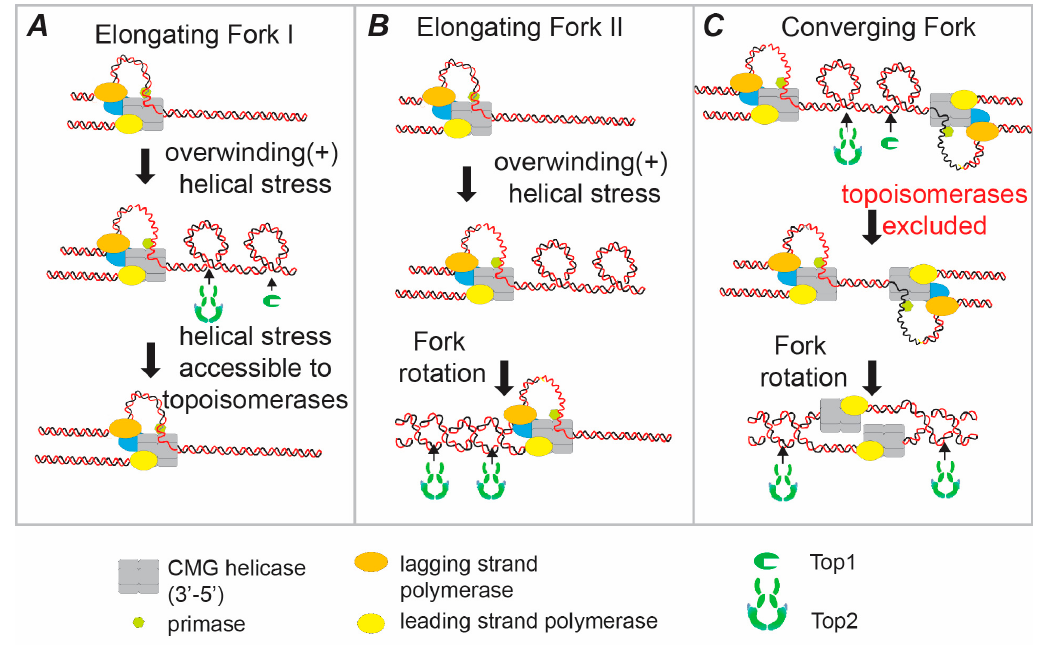
Figure 1. Resolving the topological stress generated by replicative helicase action. During elongation of DNA replication, unwinding of the parental template by the replicative helicase (CMG) separates the parental strands, but does not resolve the intertwining that exists between them. The intertwines between the strands are displaced into the region ahead of the fork leading to overwinding and positive (+) helical stress (shown in figure as positive supercoils). There are two pathways to relax this stress before it arrests ongoing DNA replication—topoisomerase action and fork rotation. ( A ) The tension is directly resolved by the action of either a type IB topoisomerase (such as eukaryotic topoisomerase I (Top1)) or a type II topoisomerase (such as eukaryotic topoisomerase II (Top2)). These topoisomerases act effectively as “swivelases” ahead of the fork. ( B ) Champoux and Been (see text) proposed a